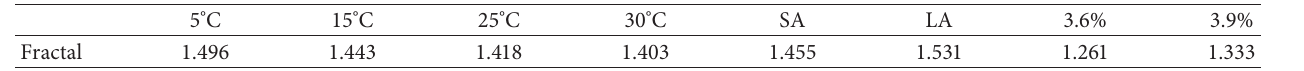
Figure 4: Fracture diagram of specimens and a binary image of a LSAM specimen (asphalt aggregate ratio � 3.6%). Table 7: Test results of fractal dimensions for